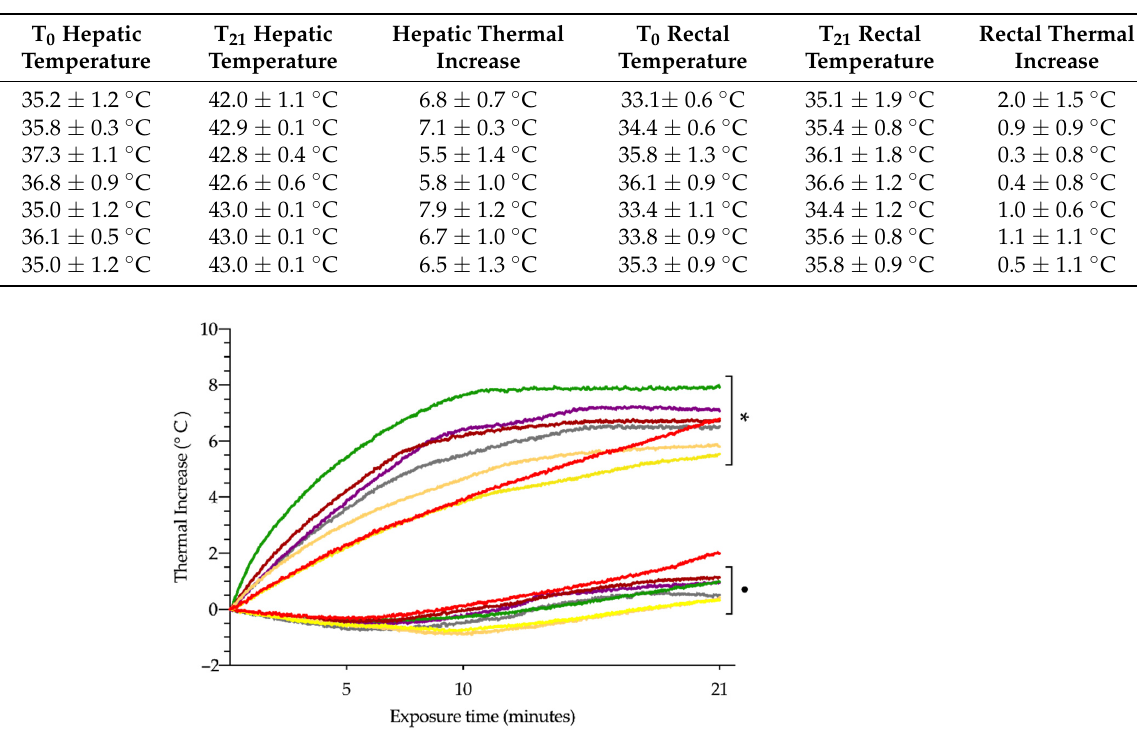
Figure 3. Thermal increase in both liver tissue (asterisk) and rectum (dot) after exposure to alternating magnetic field (AMF), with different combinations of intensity and frequency: 14 kA/m and 591 kHz (G1, red); 18 kA/m and 591 kHz (G2, purple); 16 kA/m and 591 kHz (G3, yellow); 13.7 kA/m and 700 kHz (G4, orange); 14.4 kA/m and 774 kHz (G5, green); 11.2 kA/m and 856 kHz (G6, garnet), and 10.3 k kA/m and 928 kHz (G7, grey).